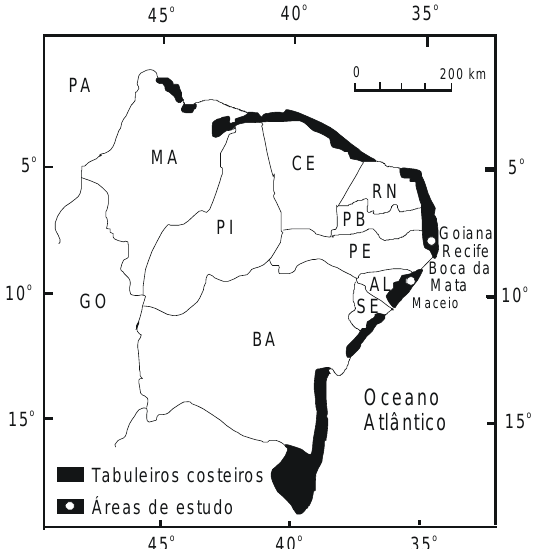
Figura 1. Mapa de localização das áreas de